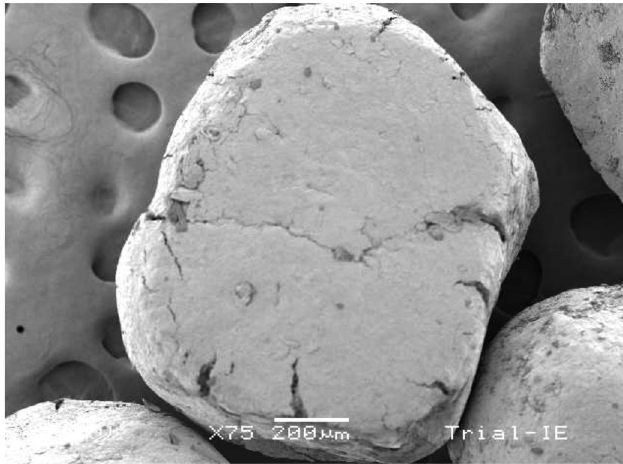
FIGURE 5 - Scanning electron micrograph of